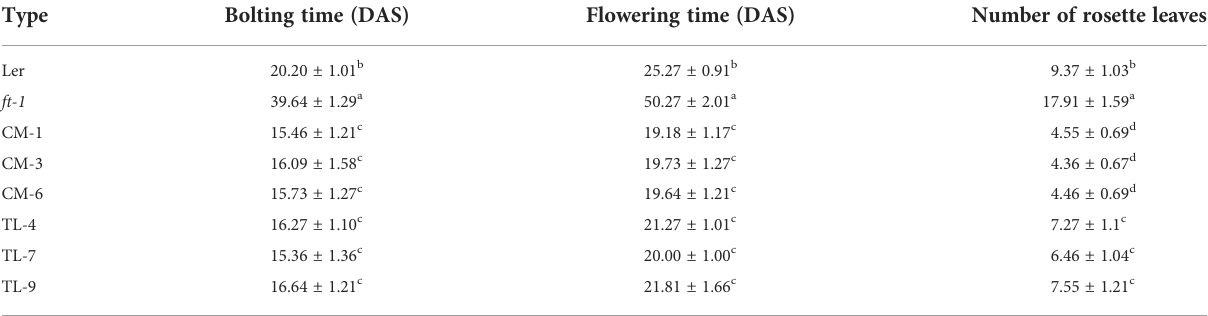
TABLE 2 Bolting traits of Ler, ft-1 , complemented mutant (CM), and transgenic Ler (TL) Arabidopsis .